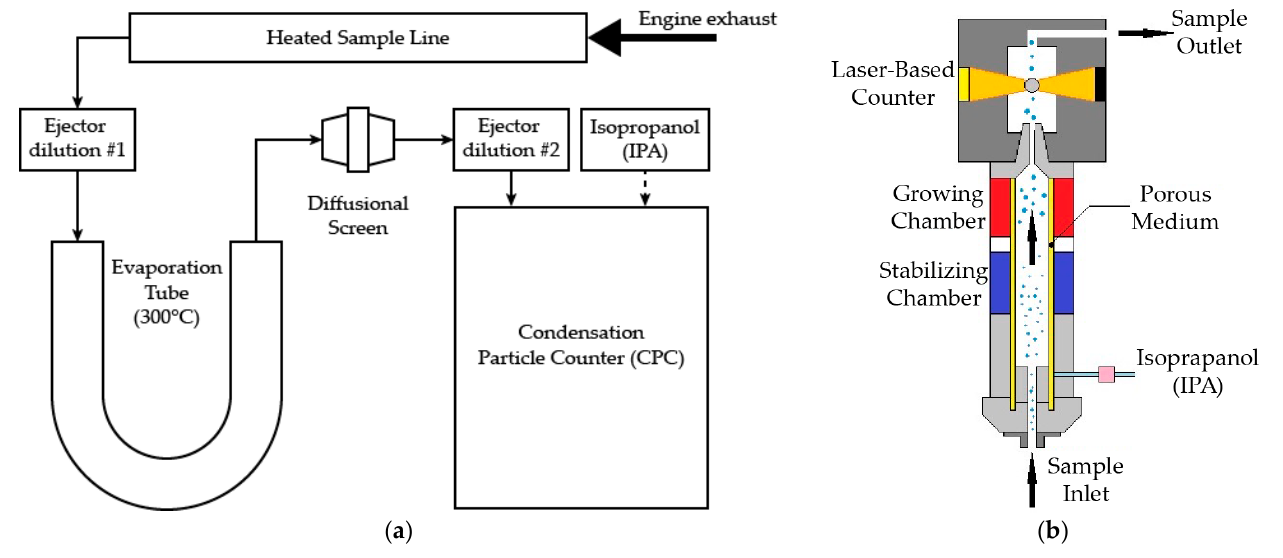
Figure 2. Flow diagram of ( a ) low cost CPC: APA and ( b ) CPC detector. Table 1. Specifications of CPC detector.